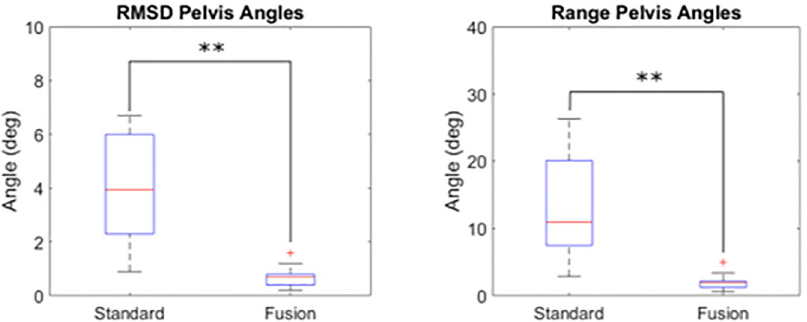
Fig 5. Overview of the differences of variability for the pelvic angles with the standard method and fusion method ( �� for p < 0.001).